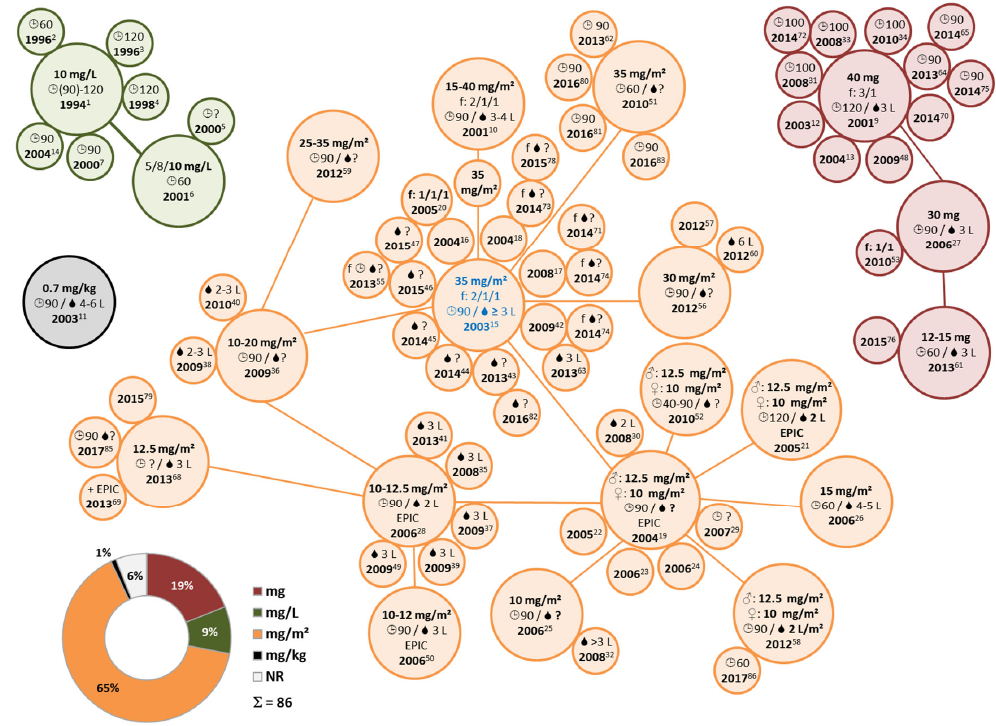
Figure 4. Overview of HIPEC protocols using MMC: Depiction of different drug dosages and measures thereof (pie chart with percentages) among protocols using MMC ( n = 86). Connections and circle sizes are arbitrary and protocols were compiled manually, according to respective similarities.